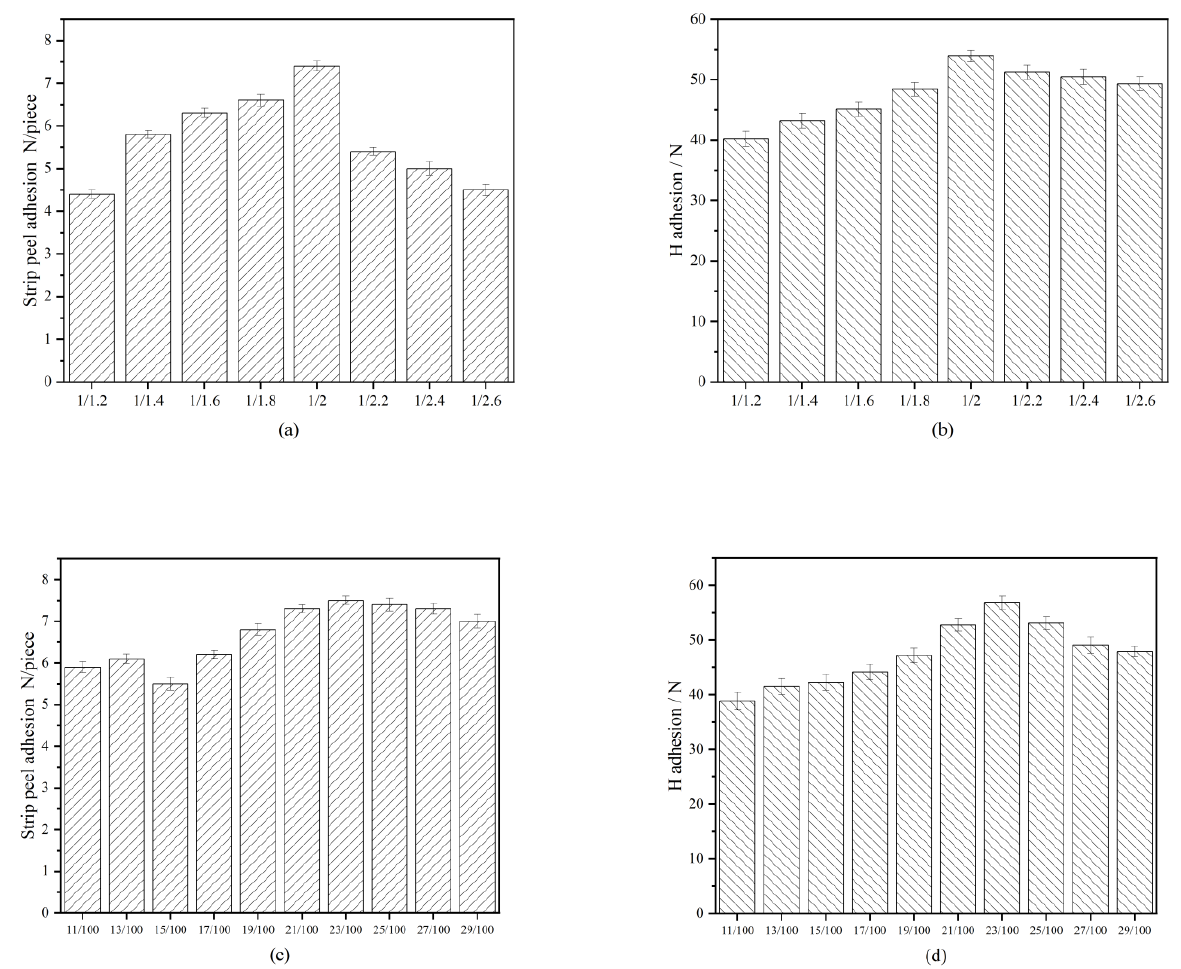
Figure 7. Adhesion strength ( a ) strip peeling adhesion and ( b ) H pull-out test of different m- cresol/formaldehyde molar ratios values. ( c ) The strip peeling adhesion and ( d ) H pull-out test of different wet weight ratios of m-cresol formaldehyde resin/latex dipping emulsion.